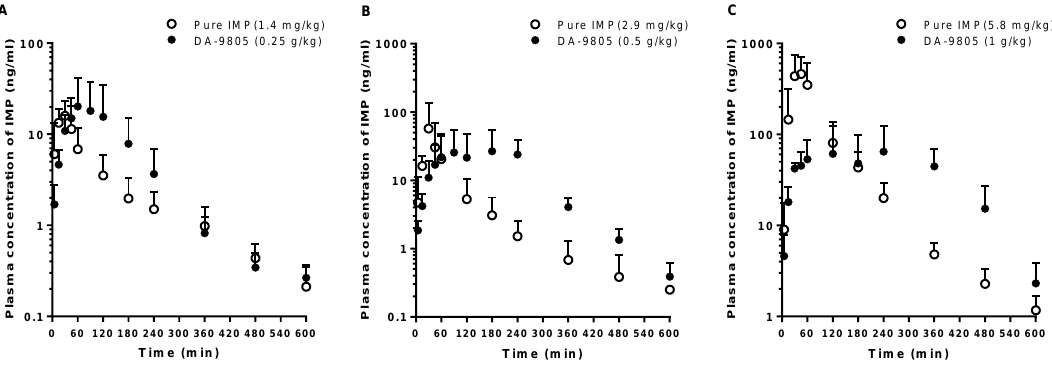
Figure 5. Mean arterial plasma concentration–time profiles of IMP following oral administration of DA-9805 (closed circle) at doses of 0.25 g/kg ( A ; 1.4 mg/kg as IMP, n = 5), 0.5 g/kg ( B ; 2.9 mg/kg as IMP, n = 5), and 1 g/kg ( C ; 5.8 mg/kg as IMP, n = 5) mg/kg and equivalent doses of pure IMP (open circle; 1.4 mg/kg ( A ; n = 6), 2.9 ( B ; n = 6), and 5.8 mg/kg ( C ; n = 5)) to rats. Vertical bars represent SD.